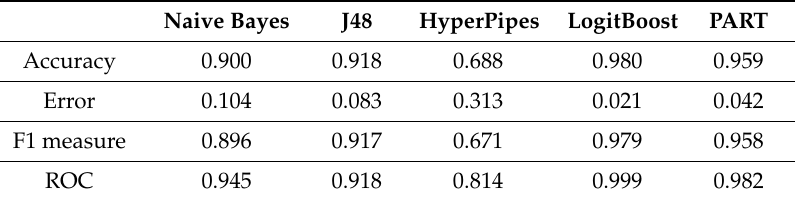
Table 3. Performance indicators obtained by the classification algorithms.